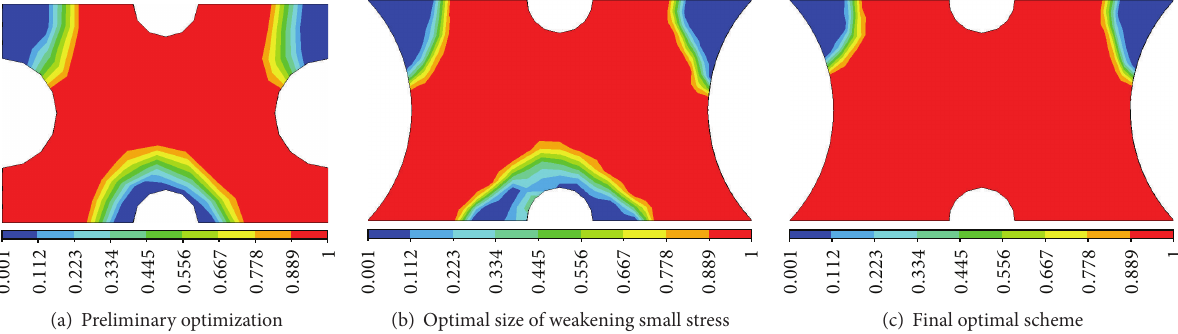
Figure 10: Optimization process of boundary optimized model.